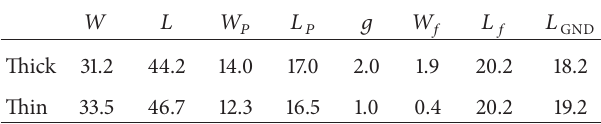
Table 2: Design parameters of the wideband